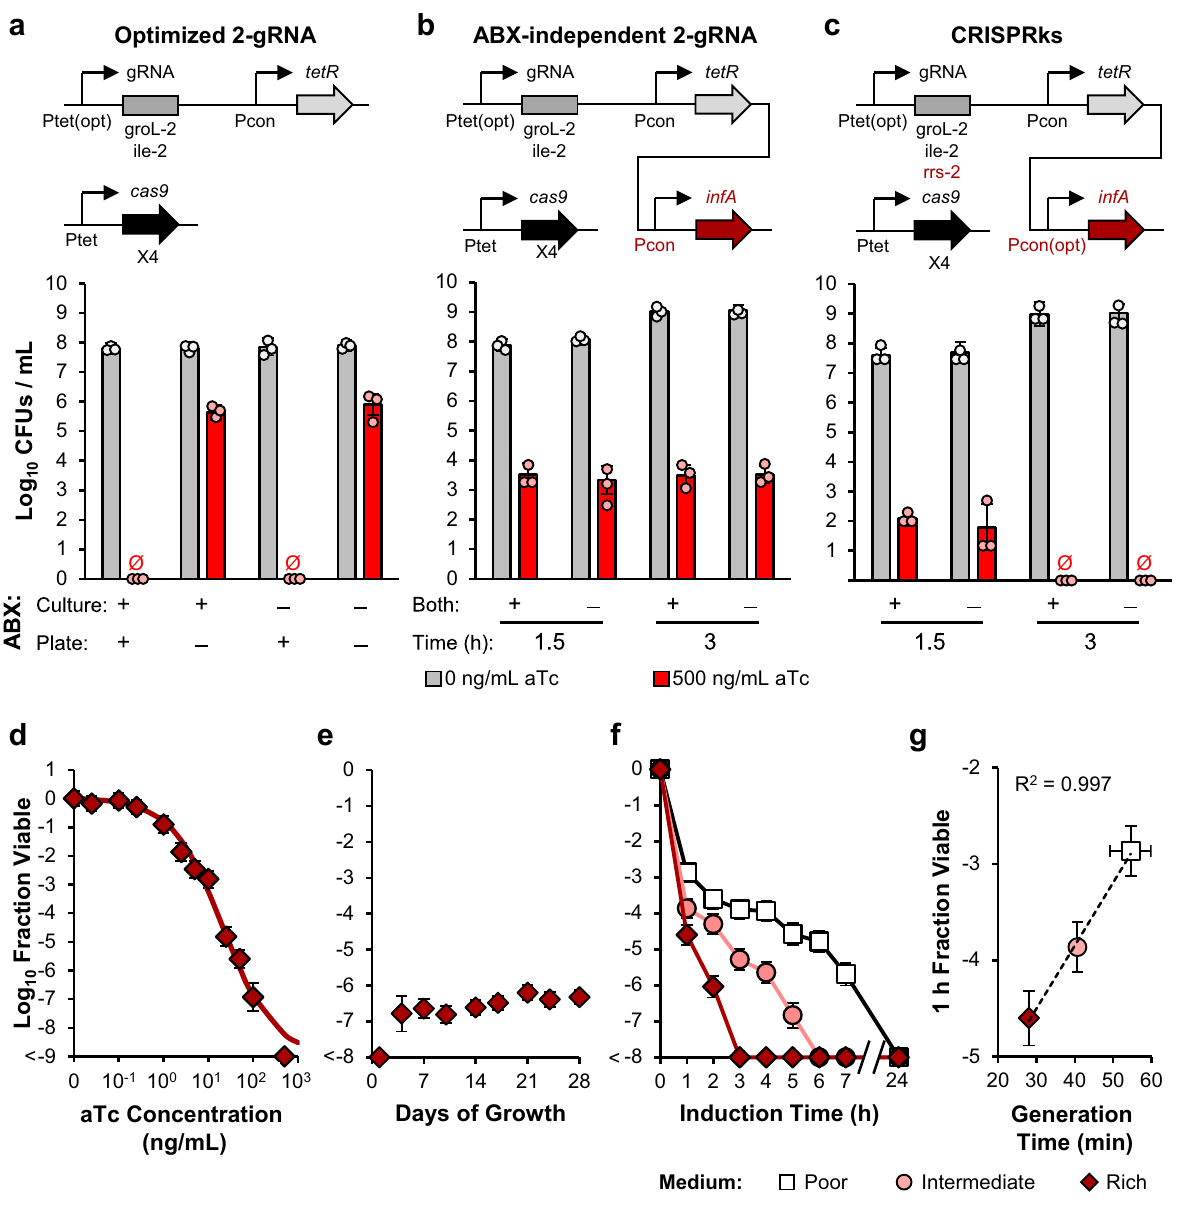
Fig. 2 Eliminating the reliance on antibiotics for ef fi cient killing. a – c System schematics and log 10 CFU values for the following kill switch strains: a optimized 2-gRNA circuit, which has four genome-integrated P tet - cas9 expression cassettes (X4) and optimized groL-2 and ile-2 P tet -gRNA expression cassettes, b ABX-independent 2-gRNA circuit, which has four genome-integrated P tet - cas9 expression cassettes (X4), optimized groL-2 and ile-2 P tet - gRNA expression cassettes, and an unoptimized constitutive infA expression cassette to complement a genomic infA knockout, and c CRISPRks, which has four genome-integrated P tet - cas9 expression cassettes (X4), optimized groL-2, ile-2, and rrs-2 P tet -gRNA expression cassettes, and an optimized constitutive infA expression cassette to complement a genomic infA knockout. Exponential phase cells for each strain were induced with 0 and 500 ng/mL aTc for 1.5 h ( a ), and 1.5 or 3 h ( b and c ) in LB with and without spectinomycin. CFUs were determined by plating onto LB agar with and/or without spectinomycin. Differences between the circuit in a and the circuits in b and c are highlighted in the construct schematics in red. gRNA , tetR , and infA cassettes are located on the same plasmid (connected lines), while cas9 is located exclusively in the genome. ‘ Both ’ denotes whether antibiotics were present in both the liquid and solid phase media. d aTc-inducible killing transfer curve for the CRISPRks strain after 3 h of induction in LB without antibiotics. Points represent experimental data while the line represents the fi tted curve. e Long-term stability assessment of the CRISPRks strain. Each day for 28 days, three replicates of the strain were diluted 250X into fresh LB without antibiotics and grown for 24 h. Every 3 – 4 days, exponential phase cells were induced with 0 and 500 ng/mL aTc for 3 h and plated on LB agar without antibiotics for CFU quanti fi cation. f Log 10 Fraction Viable of the CRISPRks strain in response to 500 ng/mL aTc in M9 + 0.4% glucose (poor), M9 + 0.4% glucose + 0.2% casamino acids (intermediate), and LB (rich). g Correlation between generation time and fraction viable. Fraction viable values of < − 8 or < − 9 had no colonies obtained from cultures receiving aTc. Values and error bars are the average and standard deviation of biological triplicate, respectively. See also Supplementary Figs. 2, 3 and Supplementary Table 1. Source data are provided as a Source Data fi